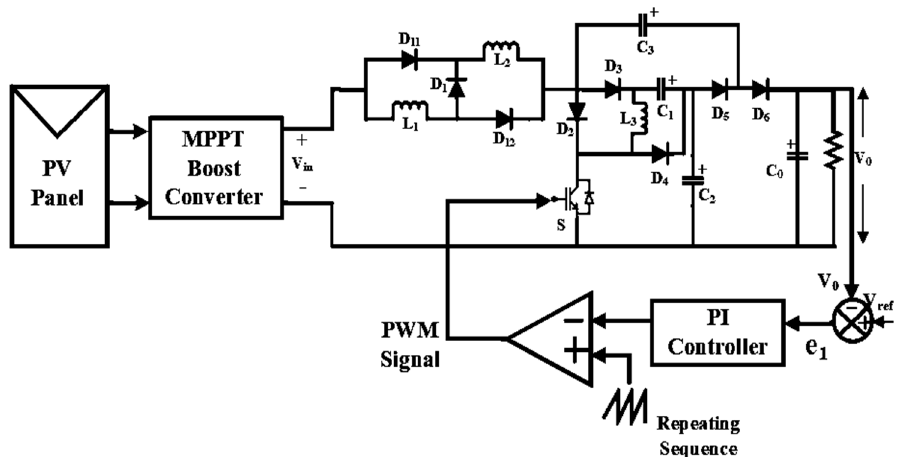
Figure 11. Block diagram of closed-loop control for proposed HG-SIQBC.